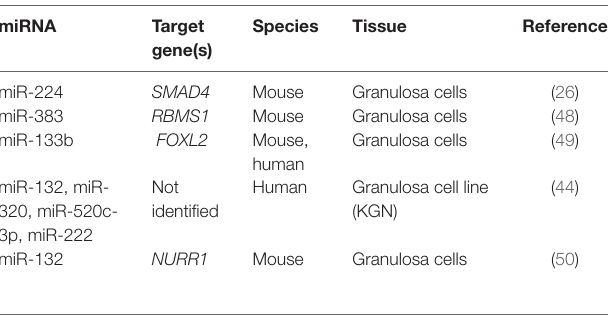
TABLe 2 | MicroRNAs that increase estradiol release.